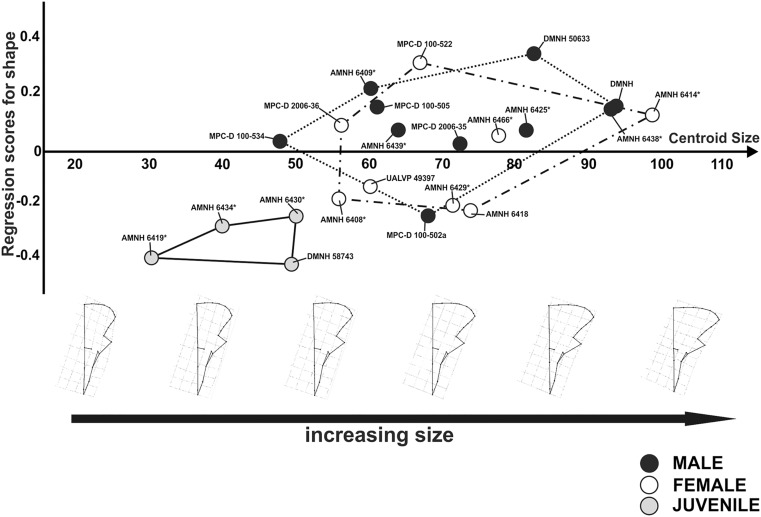
Visualization of shape-size relationship via CCA analysis for cranial shape in dorsal view and relative cranial shape changes associated with the increase of size.Asterisks indicate specimens shared with Dodson [25].